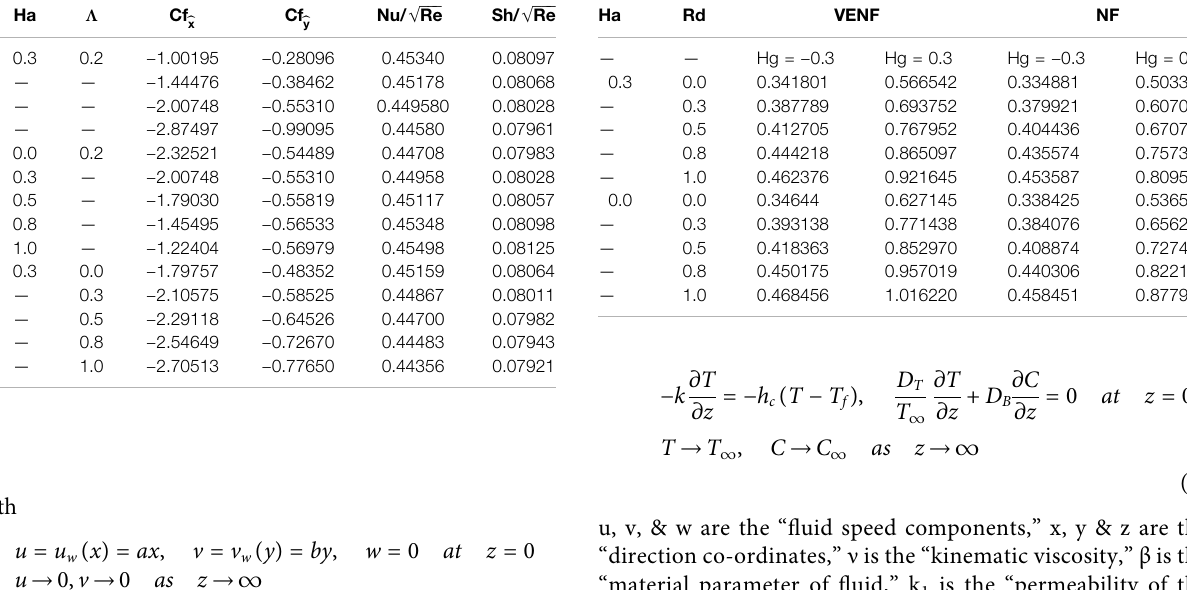
TABLE 3 | Skin friction coef fi cients, local Nusselt number, and Local Sherwood number for different values of K, Q, and Λ . K Ha Λ Cf (cid:1) x